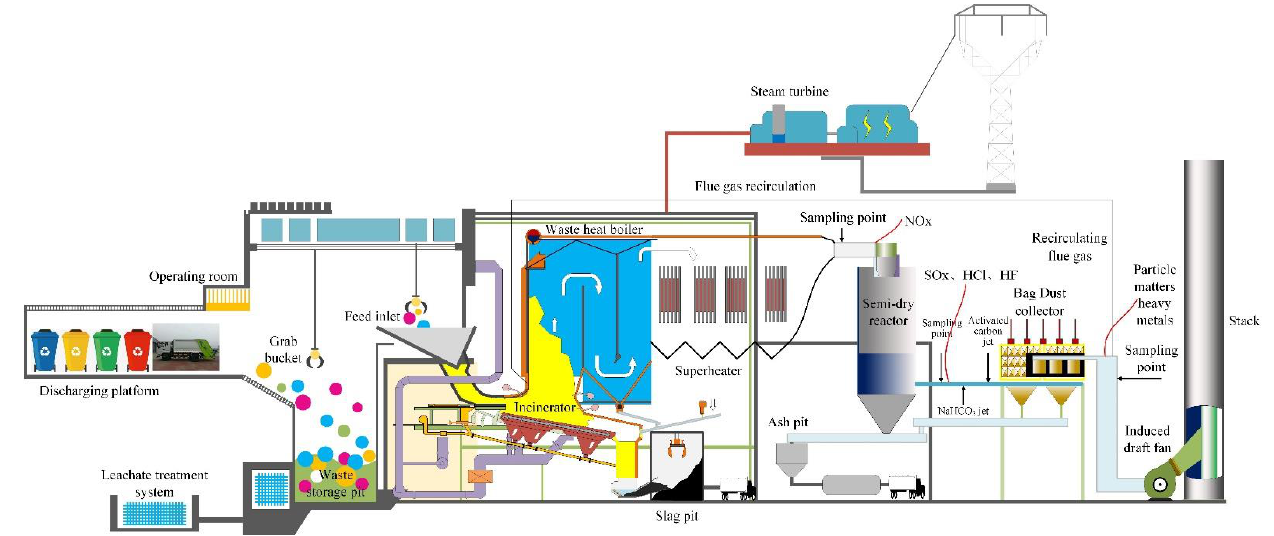
Figure 1. Schematic diagram of the MSW incinerator power plant.